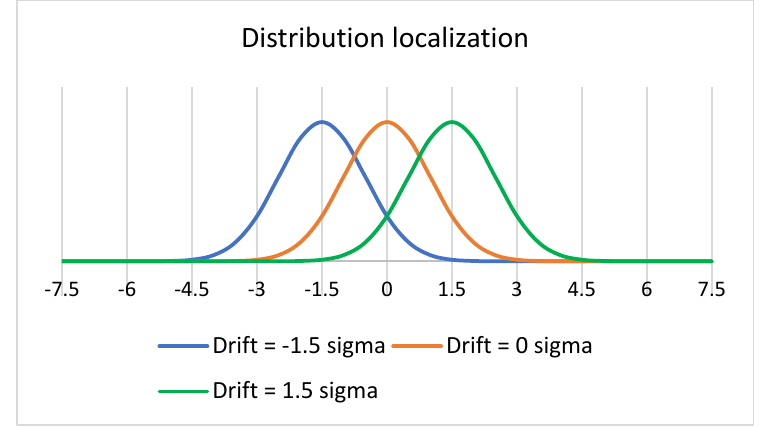
Figure 2. The concept 1.5 σ shift for the 6 σ process distribution.